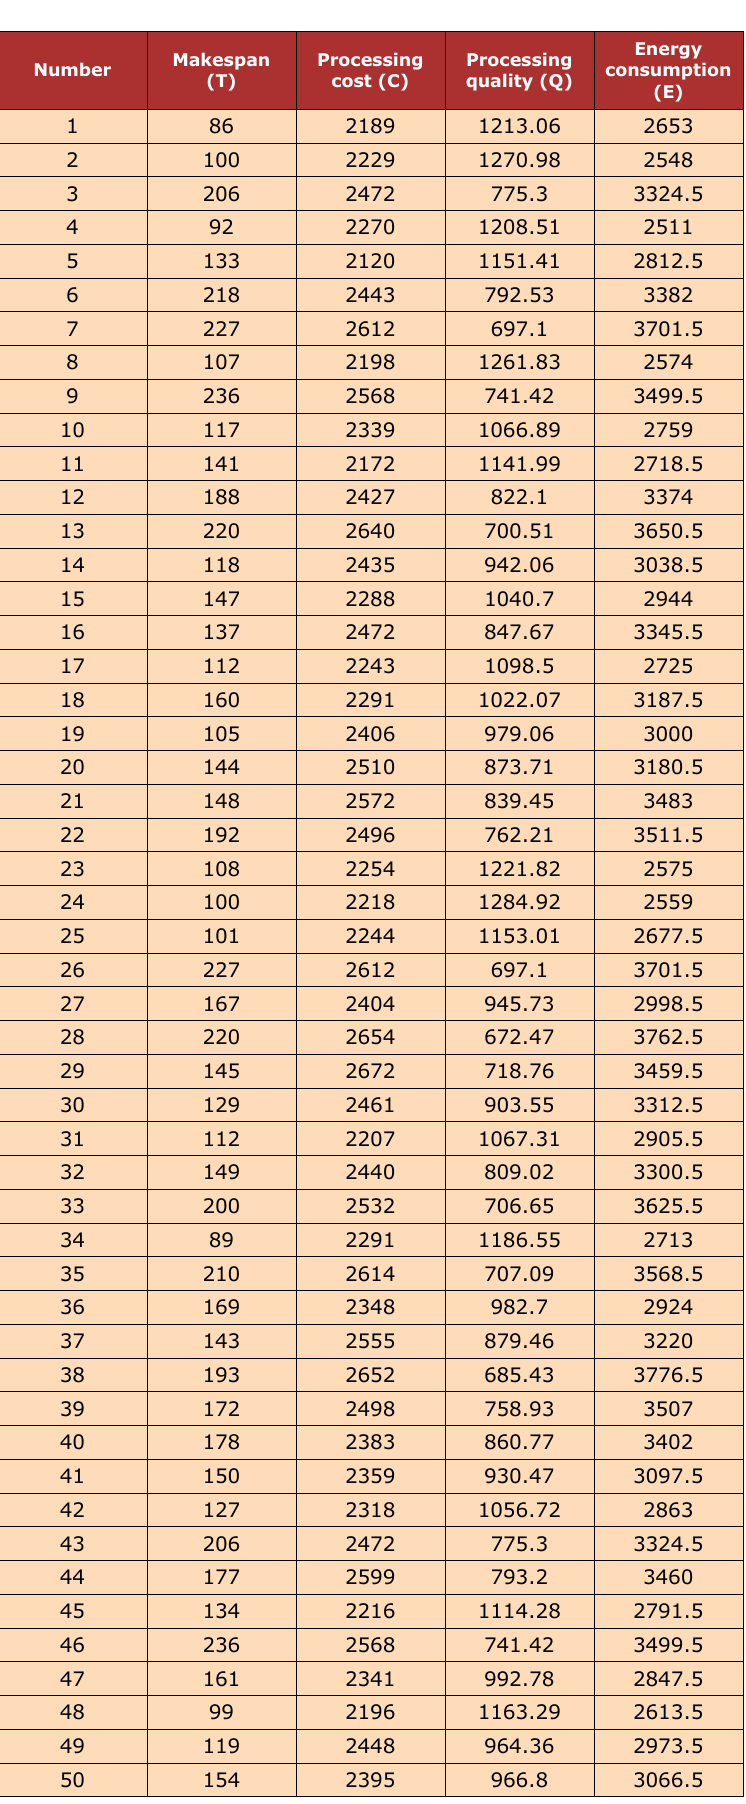
Table 2. The Pareto optimal set of the final